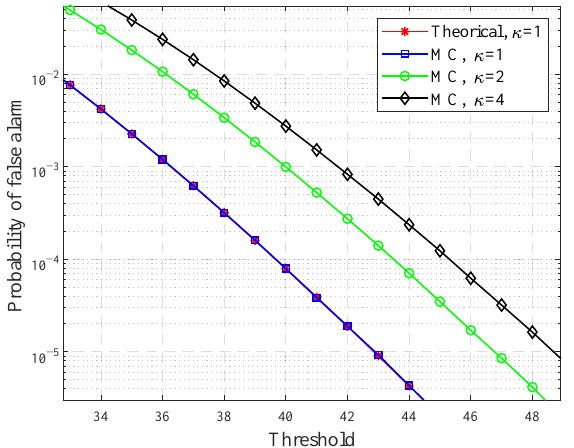
Figure 6. P fa versus the test